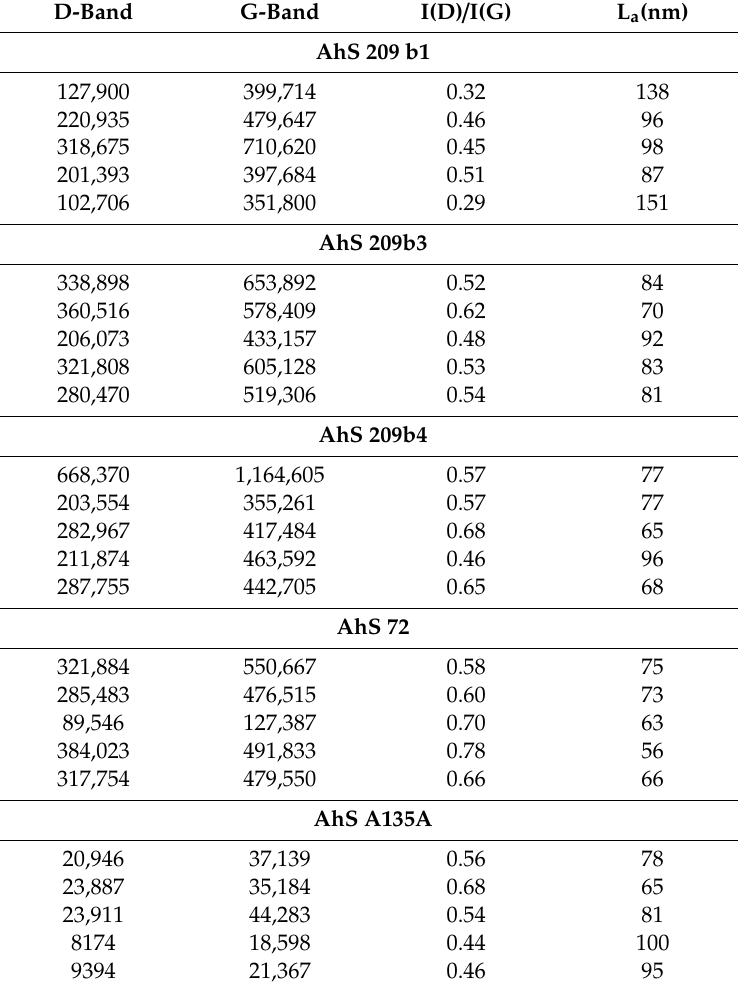
Table 1. Integrated intensities of the D- and G-bands, (I(D) / I(G) which is the ratio of the integrated intensities of the D and G band and the crystallite size of graphite (L a ) of all micro-Raman Spectroscopy (MRS) acquisitions of AhS samples. For the intensity ratios, I(D) / I(G), the standard deviation is 0.08. For La, the estimated uncertainty is in the order of 20